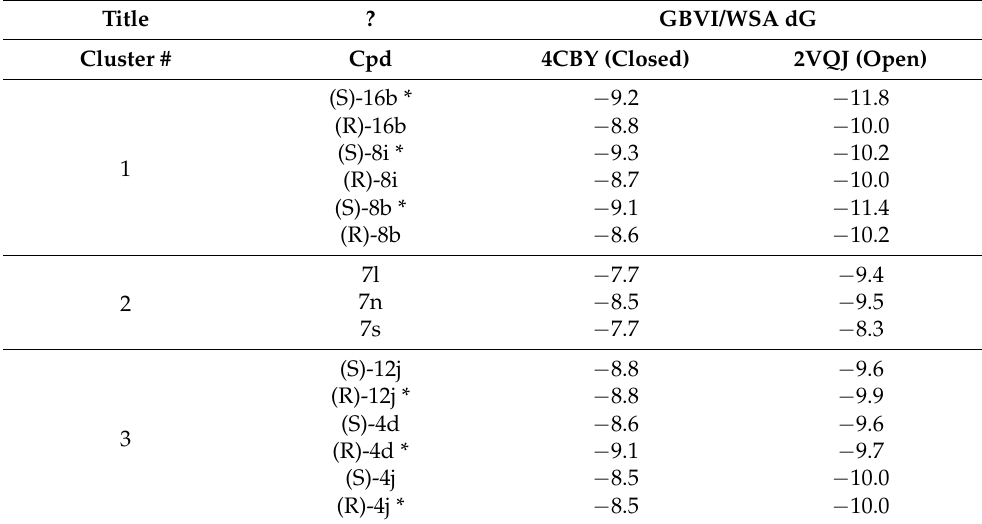
Figure 6. Docking poses of (S)-16b (dark green), (S)-8i (magenta) and (S)-8b (brown) within the binding pockets of ( A ) HDAC4 c (PDB-ID:4CBY) and ( B ) HDAC4 o (PDB-ID:2VQJ). The surface of the binding sites is colored in gray and clipped in the z-plane. The mutated amino acid residues are colored according to the corresponding docked ligand. The two lower panels show 2D ligand interactions of representative compound (S)-16b docked to ( C ) HDAC4 c and ( D ) HDAC4 o . Table 2. Docking scores of indicated compounds into HDAC4 c (PDB-ID 4CBY) and HDAC4 o (PDB-ID